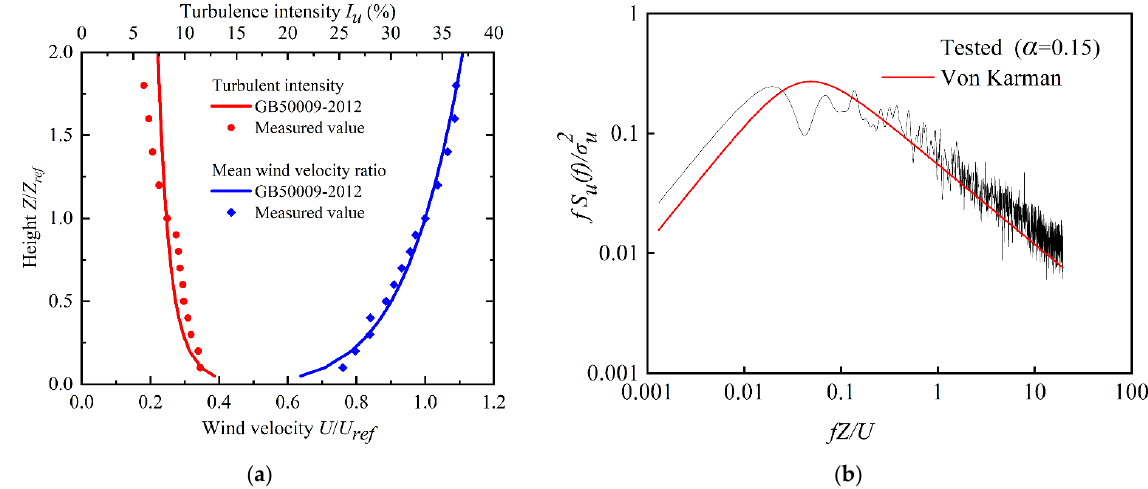
Figure 5. Boundary layer simulation results: ( a ) Wind velocity and turbulence intensity profiles; ( b ) Wind velocity power spectrum. ( b ) Wind velocity power spectrum.